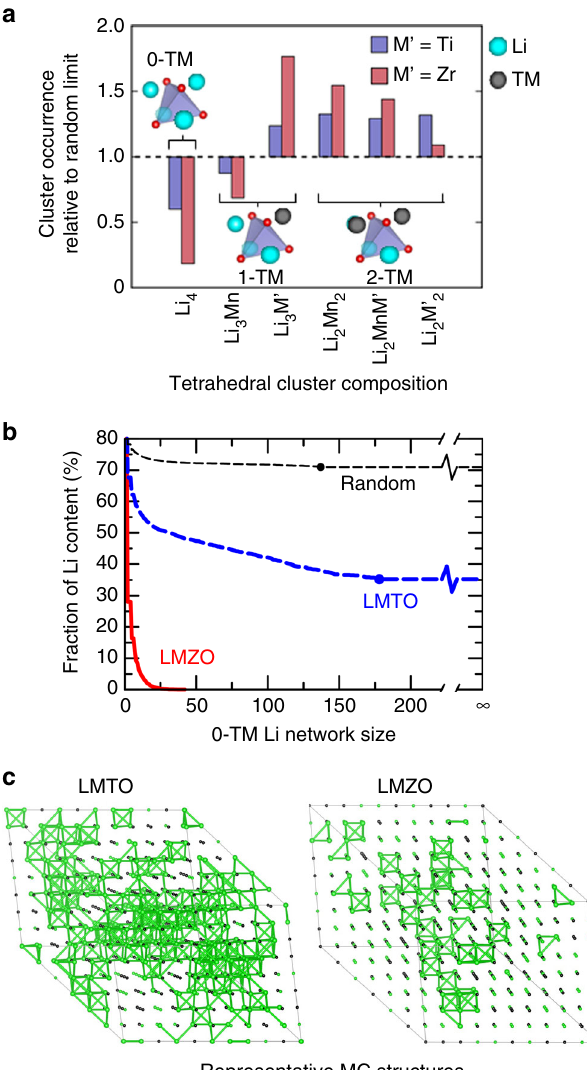
Fig. 4 Local cation cluster and macroscopic Li connectivity analysis based on MC-derived structures for LMTO and LMZO at 1000 °C. Each MC structure contains 480 cation sites, of which 288 are decorated with Li ions. a Occurrence of various tetrahedral clusters (0-TM, 1-TM, 2-TM) in LMTO (blue) and LMZO (red) as compared to the random limit. b Connectivity plots of LMZO and LMTO showing the fraction of Li content in networks of at least a certain number of Li sites. A Li network is de fi ned as all the Li sites that are inter-connected through 0-TM channels. Each plot is averaged over 600 sampled MC structures. The result for a random cation distribution with the same Li to TM ratio is also plotted as a reference. The plots are truncated at the percolating Li contents (marked by dots) and extended to in fi nity for LMTO and the random case. LMZO is not percolating. c Representative MC structures for LMTO and LMZO. Li ions are labeled with green spheres and 0-TM connected Li sites are bridged with green